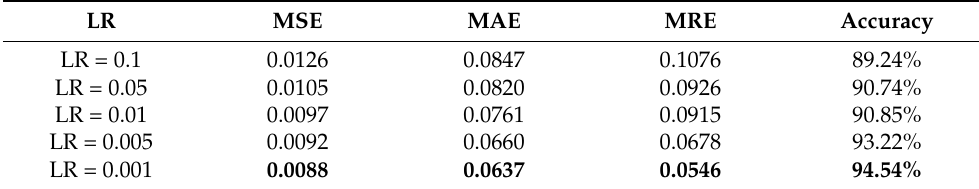
Table 5. Influences of learning rates at A 1 .